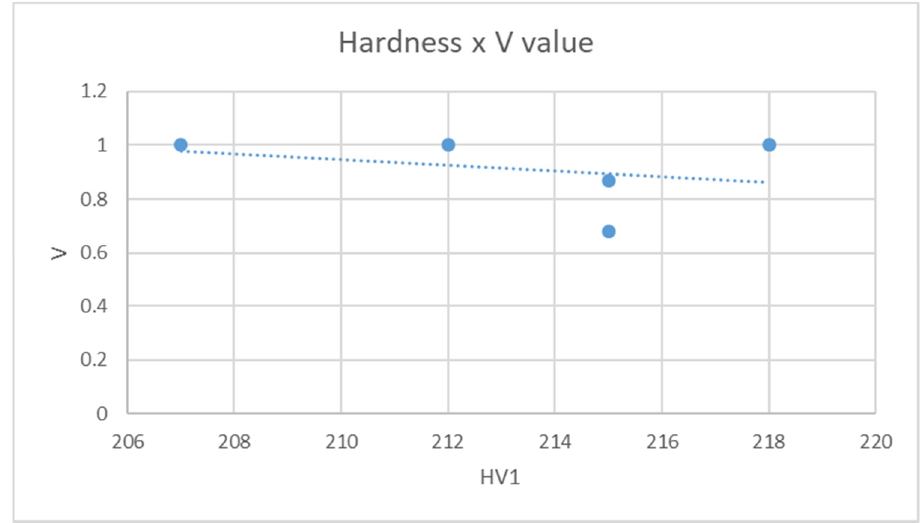
Figure 9. Correlation between hardness and V-value.